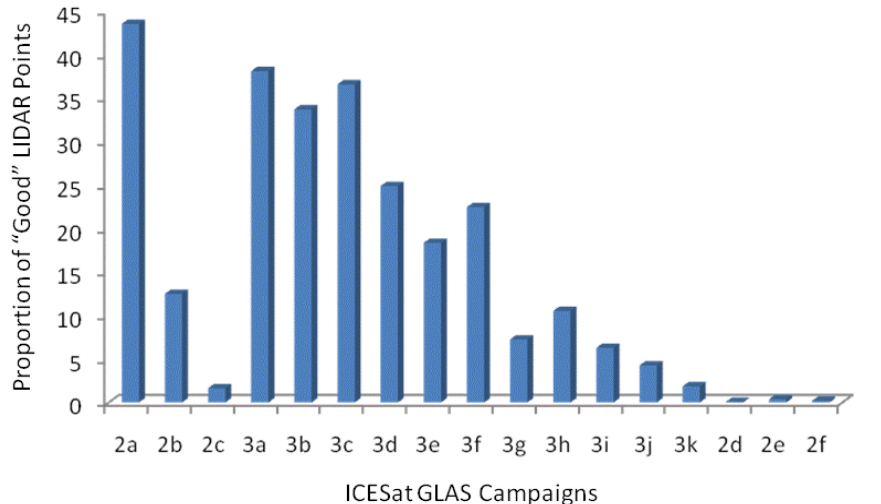
Figure 3. Proportion of good data ( i.e. , gain values ≤ 30) acquired over the Cerrado biome during the GLAS 17 campaigns (90-day repeat